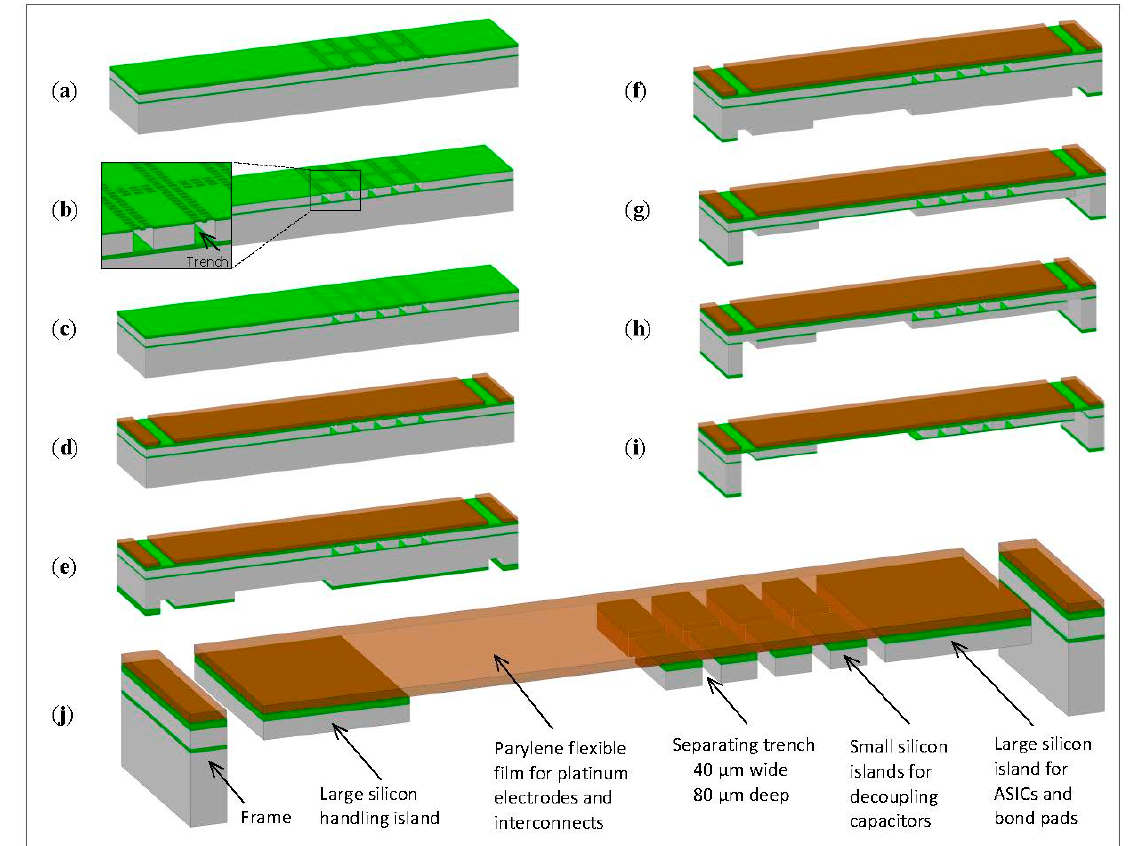
Figure 1. Fabrication flowchart of the flexible device with 80 µm thick silicon islands integrated with parylene interconnects: ( a ) Deposition and patterning of the SiO 2 mesh-shaped mask on an SOI substrate; ( b ) Definition of the silicon islands with trenches; ( c ) Sealing of the trenches with PECVD SiO 2 ; ( d ) Deposition and patterning of the parylene film; ( e ) Etching of the advance in the bulk silicon; ( f ) Partial removal of the back-side SiO 2 hard- etch mask; ( g ) Thinning the bulk silicon until the BOX stop layer; ( h ) Removing the exposed buried oxide layer; ( i ) Silicon islands thinning and device release; ( j ) The remaining BOX and SiO 2 stop layer